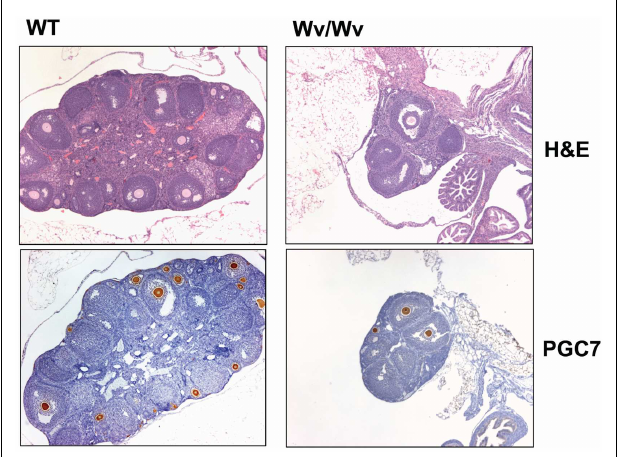
FIGURE 1 | Germ cell deficiency inWv ovaries . Ovaries from 6-week-old wild type andWv/Wv littermates were harvested and subjected to histological analysis. PGC7 staining was used as a marker for germ cells and follicles (86, 87).Wild type ovaries contain abundant PGC7-positive germ cells and follicles of various developmental phases, and in particular, germ cells and primary follicles are found immediately beneath the surface. Wv/Wv mutant ovaries are smaller and contain a greatly reduced number of germ cells.